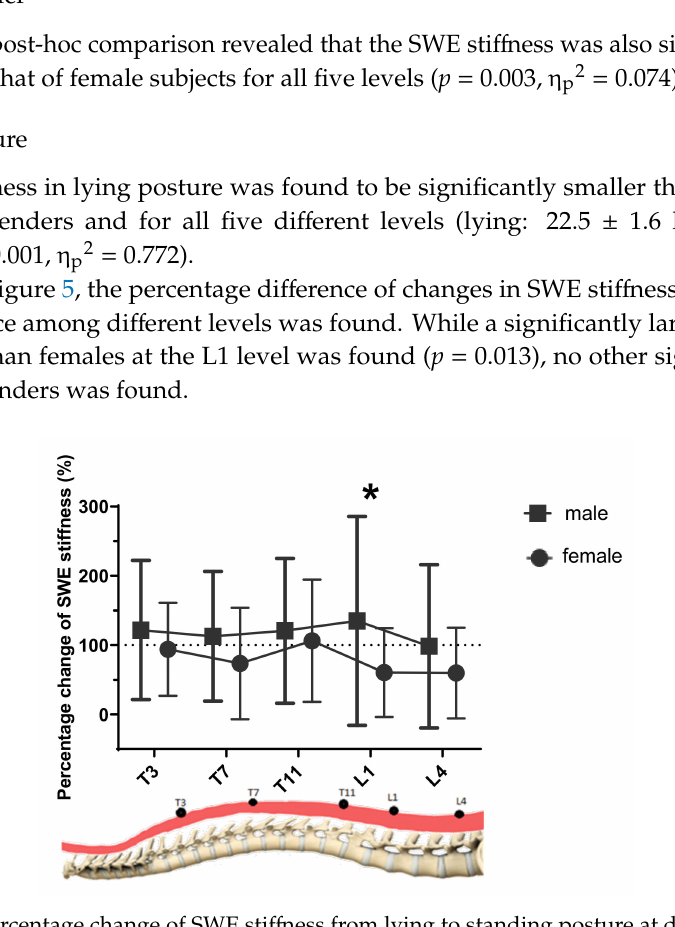
Figure 5. The percentage change of SWE sti ff ness from lying to standing posture at di ff erent levels of two genders ( n = 64). * Significant di ff erences existed in